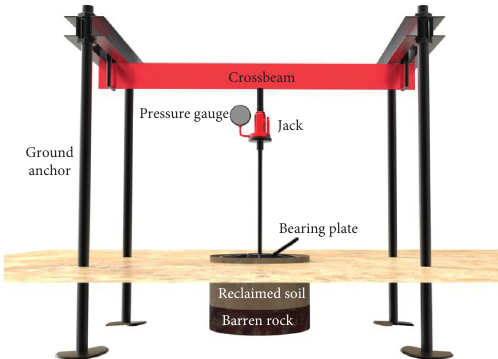
Figure 5: Illustration of the setup for plate load test.